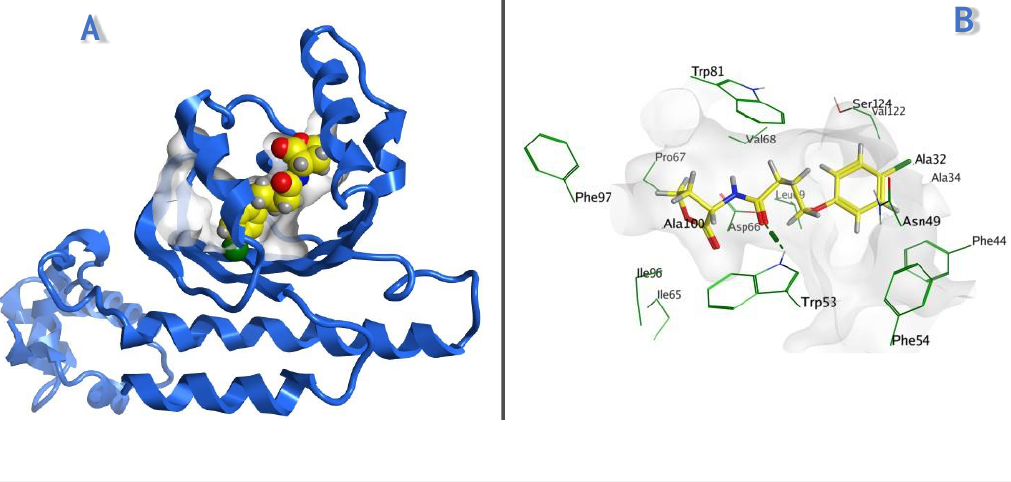
Figure 6. ( A ); 3D model of S. marcescens SmaR, HLC is in thick yellow balls indicating the binding pocket, ( B ); 3D representation of HLC (yellow sticks) in the active site showing interactions with key amino acids (green), H-bond is presented as green dots.